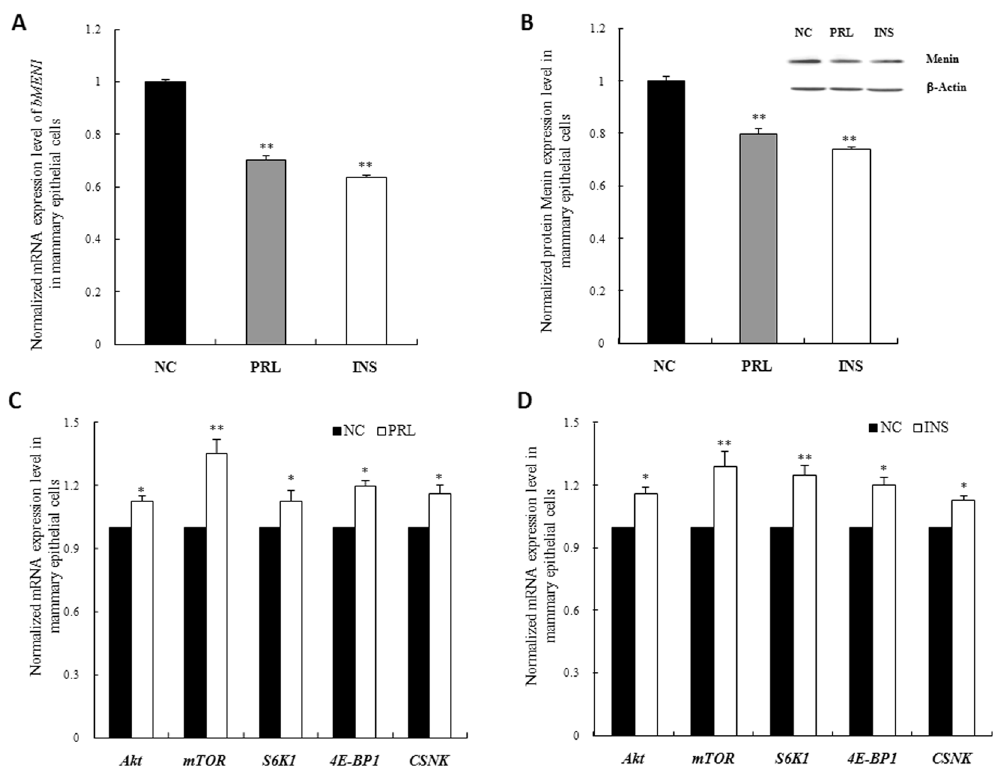
Figure 5. The endocrine hormones prolactin (PRL) and insulin (INS) modulated the expression of MEN1 / Menin and its downstream factors involved in mTOR signaling. The MEN1 mRNA ( A ) and Menin protein ( B ) level were significantly inhibited in MAC-T cells after 8 h of treatment with prolactin and insulin, compared to their saline-treated controls. The factors in the mTOR pathway, Akt , mTOR , S6K1 and 4E-BP1 , along with CSNK , were found to be upregulated upon prolactin ( C ) and insulin ( D ) treatment. As shown above, the data are relative expression levels normalized to the internal control β -actin. * P < 0.05, ** P < 0.01. Akt, also known as protein kinase ( B ) mTOR, mammalian target of rapamycin; S6K1, p70 ribosomal protein S6 kinase-1; 4E- BP1, eukaryotic initiation factor 4E (eIF4E)-binding protein 1; CSNK, κ